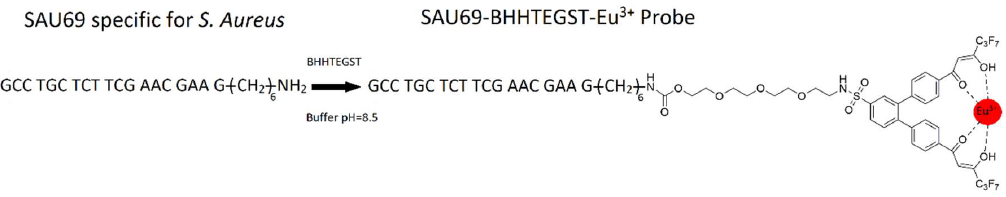
Figure 1. The SAU69 oligonucleotide that has a specificity for hybridisation to the 16S ribosomal RNA of S. aureus (with an amino group in 5′) was conjugated with Europium chelate (BHHTEGST–Eu 3+ ) to produce the SAU69-BHHTEGST–Eu 3+ probe.